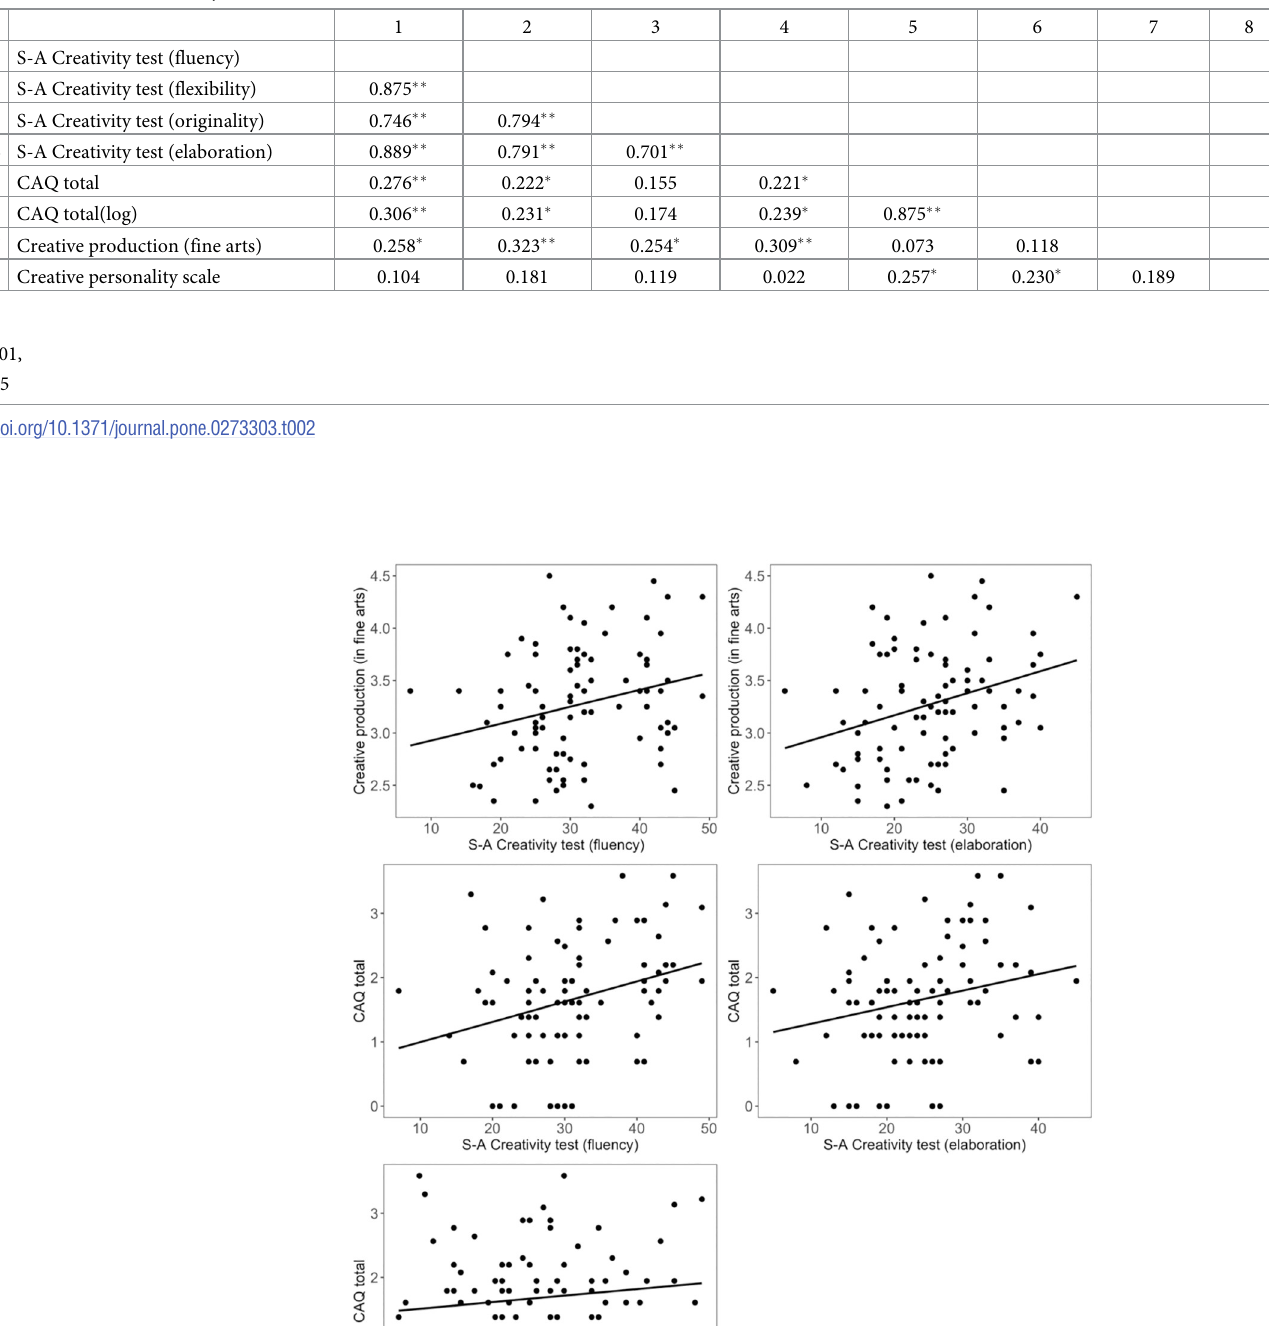
Table 2. Correlations of creativity indices.